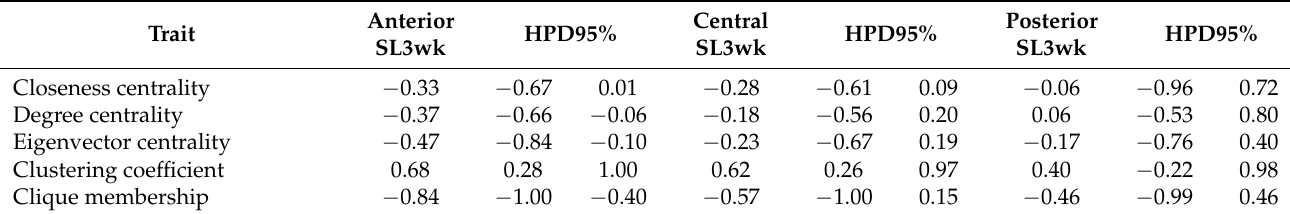
3.3. Estimating the Effects of Selection for SNA Traits on Individual and Pen-Level Lesions Animals selected to have EBVs in the lowest 10% for eigenvector centrality (EBVs mean = − 2.48 SD) had lower than average EBVs for anterior SL24h (EBVs mean = − 1.53 SD), while they had higher posterior SL24, anterior, central and posterior SL3wk (Figure